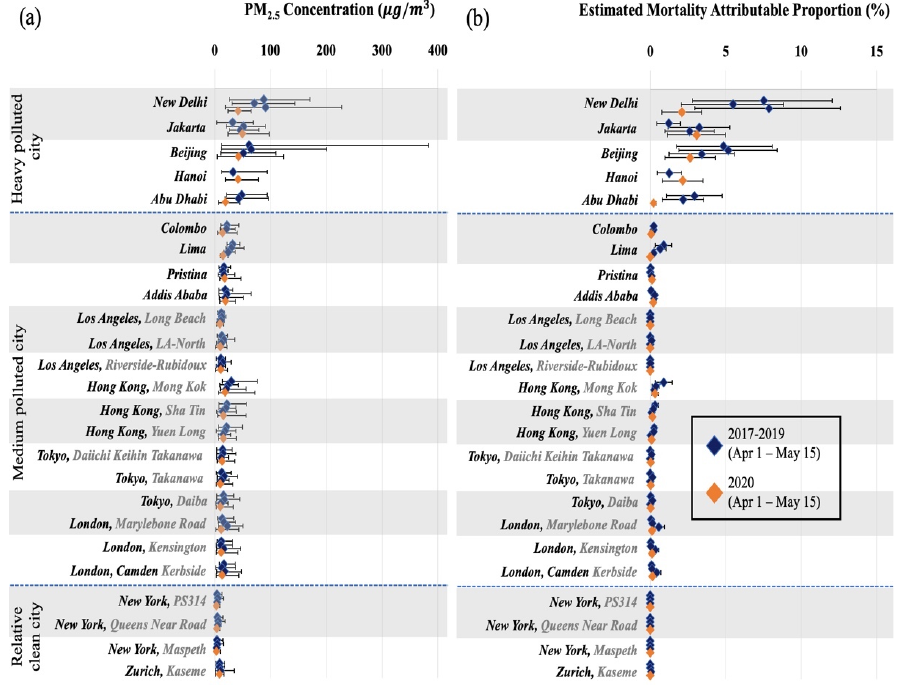
Figure 4. ( a ) Range of PM 2.5 concentration from the selected cities and ( b ) calculated range of estimated mortality attributable proportion from AirQ+.